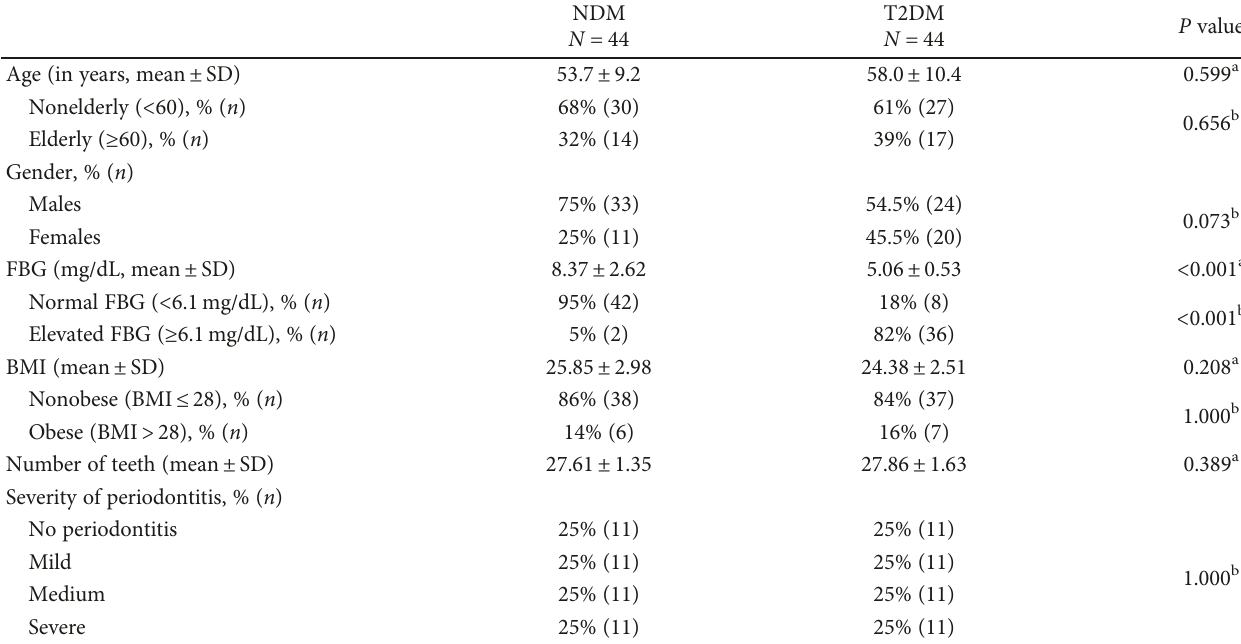
Table 2: Characteristics of individuals with (patients) and without (healthy) type 2